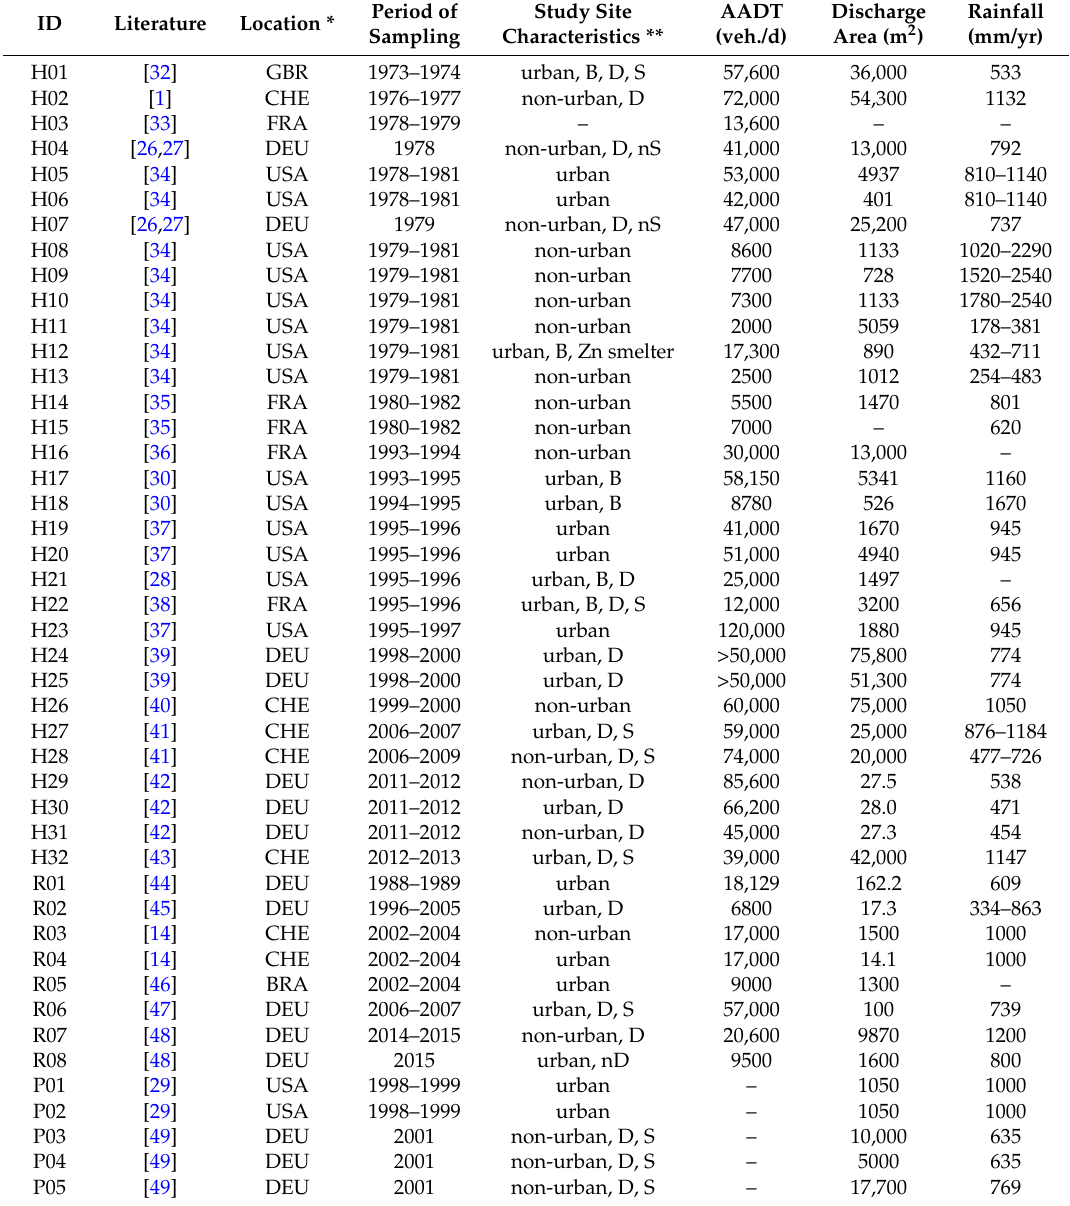
Table 1. Characteristics of traffic area sites with heavy metal loads reported in the